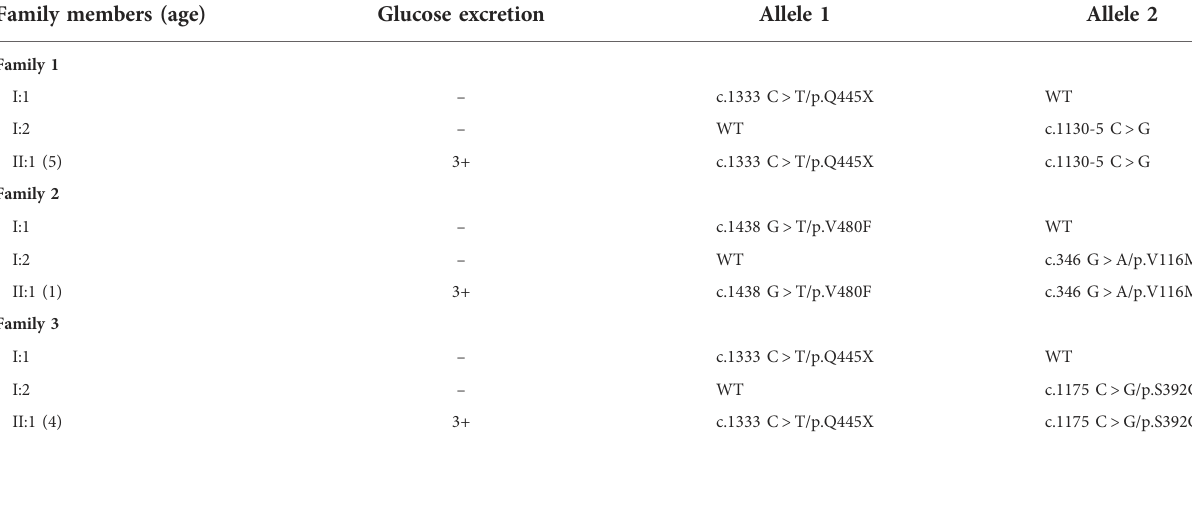
TABLE 1 Mutations in SGLT2 and glucose excretion in three Chinese pediatric patients and their parents. In column 1, “ age ” indicates at the time of evaluation. In column 2, “ - ” means within the normal range. Family members (age) Glucose excretion Allele 1 Allele